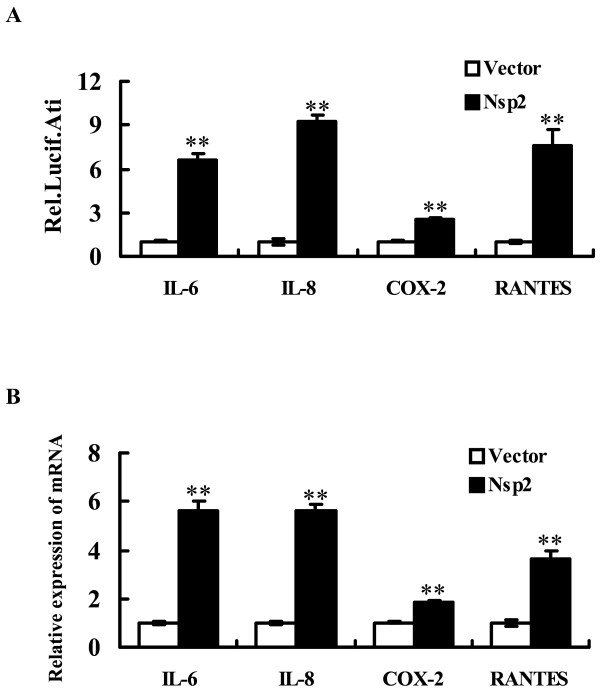
PRRSV Nsp2 significantly enhances NF-κB-regulated gene expression. (A) The wild-type Nsp2 (0.6 μg) and the empty vector were transfected into HeLa cells along with various reporter plasmids (0.2 μg) and pRL-TK (0.05 μg), respectively. Luciferase reporter assays were performed at 36 h post-transfection. The results are expressed as fold induction of IL-6, IL-8, COX-2, and RANTES promoter luciferase activity relative to the basal level. (B) HeLa cells were transfected with 1 μg of plasmid encoding Nsp2, or empty vector. After 36 h incubation, total RNA was extracted and the expression of IL-6, IL-8, COX-2, RANTES, and GAPDH genes were evaluated by real-time RT-PCR. Results are expressed as increasing mRNA levels relative to those in cells transfected with the empty vector and were normalized by using GAPDH housekeeping gene expression. All data represent the means and standard deviation of three independent experiments. **P < 0.01 as compared with vector control.